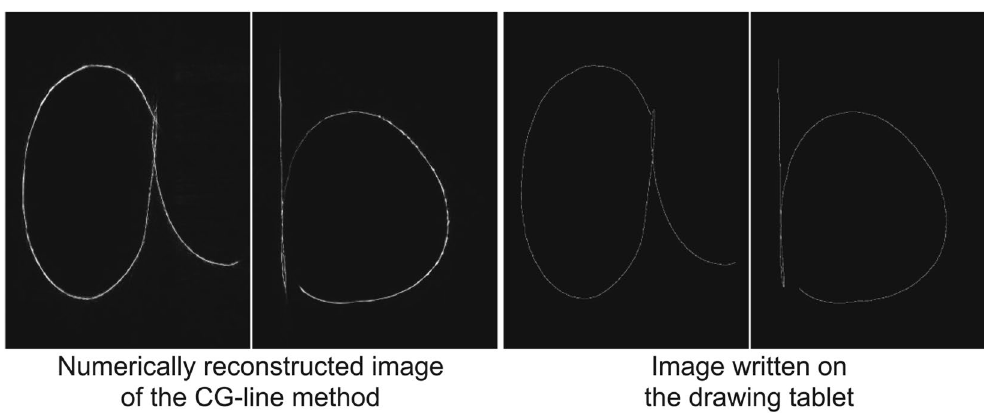
Figure 4. Numerical simulation of the reconstructed image of the hand-written letters ’a’ and